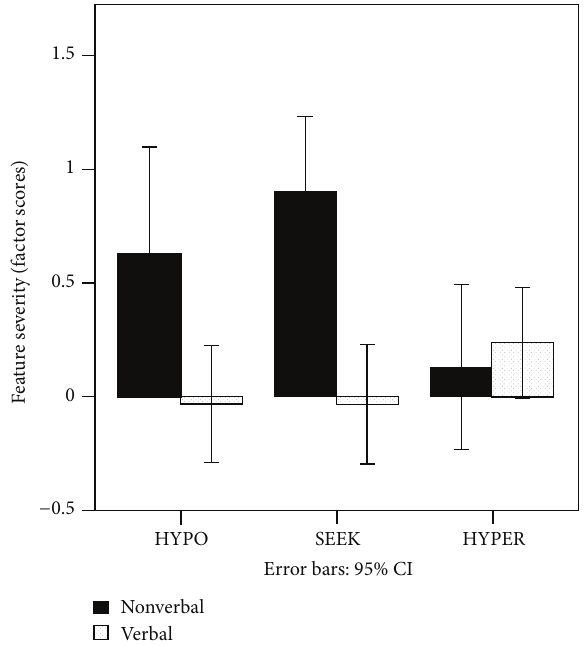
Figure 1: Level of severity of sensory response patterns for verbal and nonverbal subgroups in the cross-sectional sample.